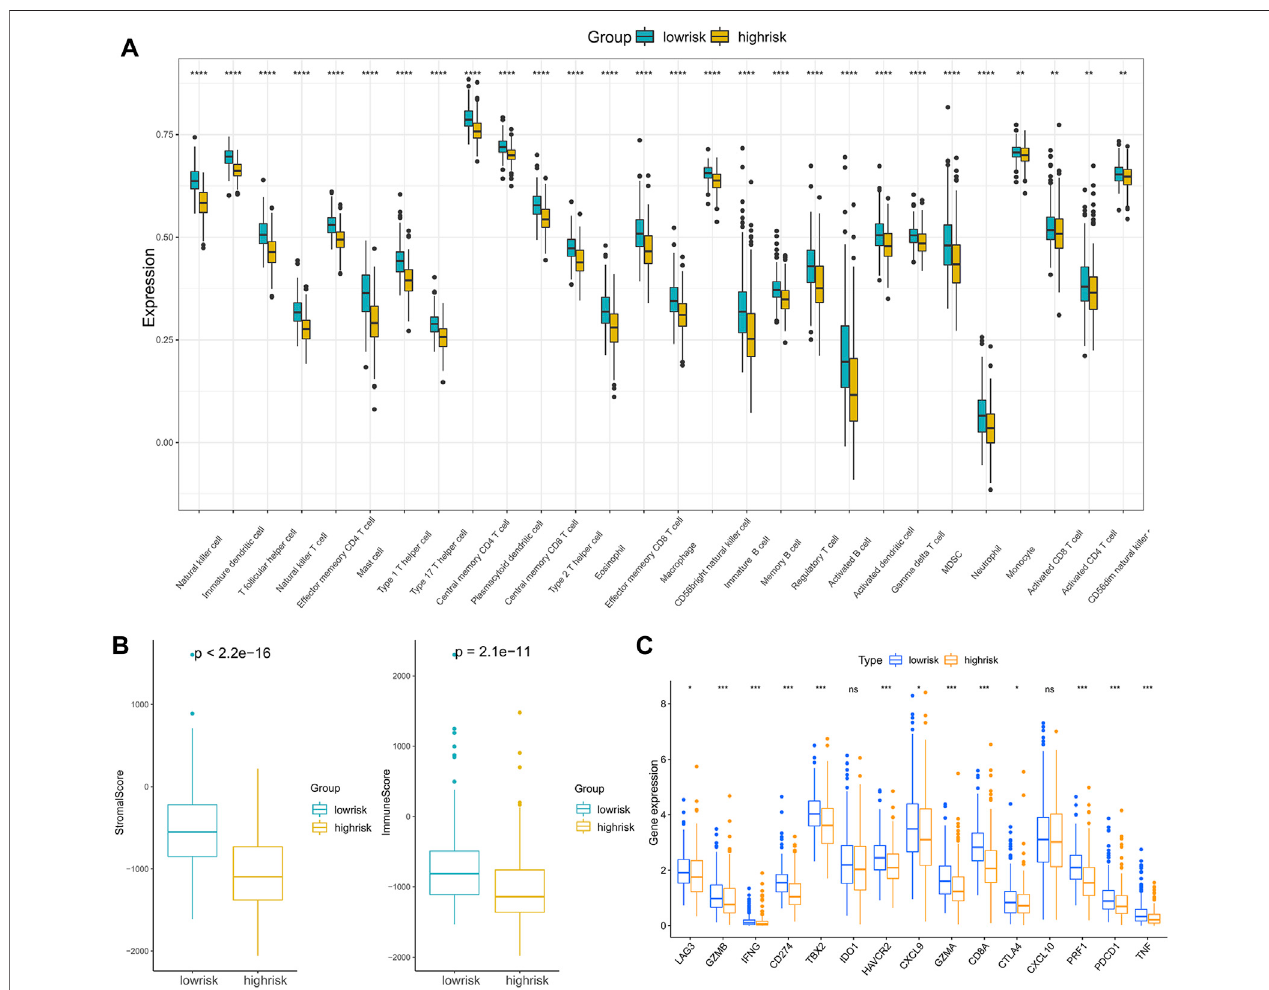
FIGURE 7 | Analysis of the correlation between the riskscore and immune cell in fi ltration: (A) The immune cell in fi ltration levels between the high- and low-risk subgroups. (B) ImmuneScore and StromalScore between the high- and low-risk subgroups. (C) The expression of immune checkpoint genes in the high- and low-risk subgroups. (* p < 0.05, ** p < 0.01, *** p < 0.001, **** p <